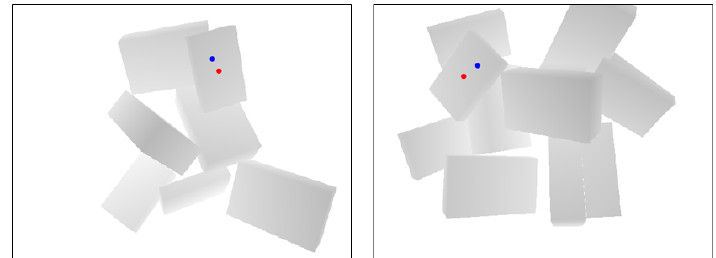
Figure 10. Planned optimal grasp point. The red and blue points are our grasp planning method and Dex-Net 4.0 outputs,